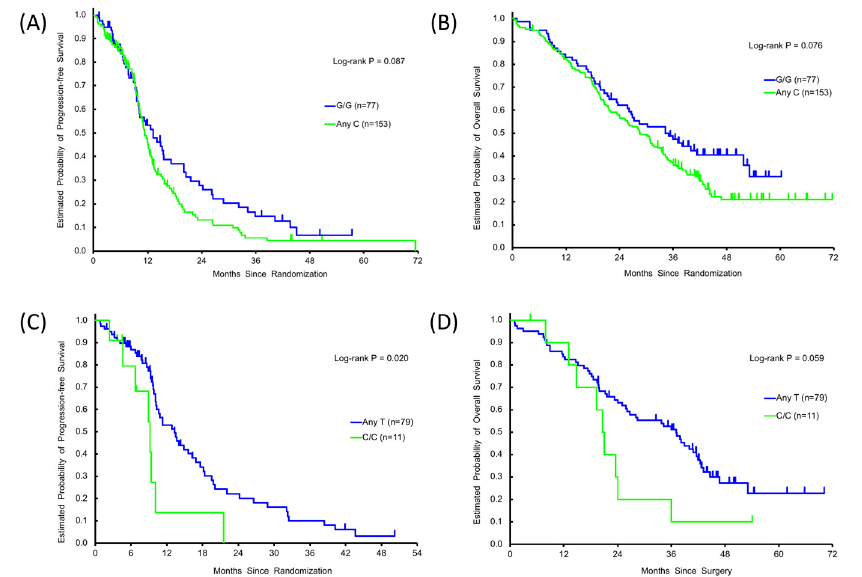
Figure 1. Single nucleotide polymorphisms (SNPs) and clinical outcomes. Progression-free survival (PFS) and/or overall survival (OS) by GTF2H1 rs4596 variants, G/G ( ― ) or any C ( ― ) in the discovery cohort ( A, B ), and by RPA2 rs7356 variant, C/C ( ― ) or any T ( ― ) in KRAS wild-type subgroup in the discovery cohort ( C, D ).